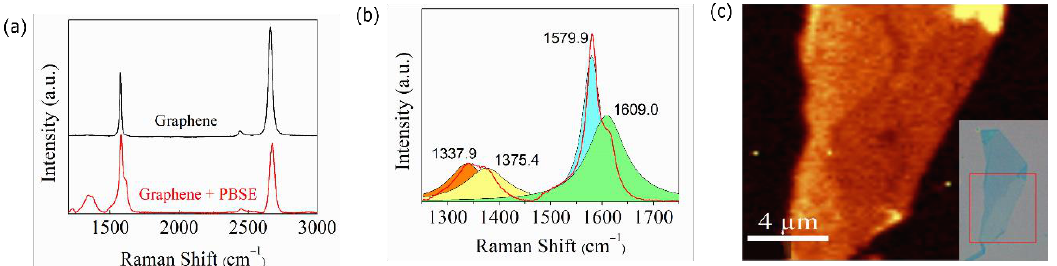
Figure 3. ( a ) Raman spectra of a graphene monolayer before (black curve) and after (red curve) 1-pyrenebutanoic acid succinimidyl ester (PBSE) immobilization. The top curve is shifted for clarity. ( b ) Raman spectrum near G band. ( c ) Raman spectra color map of the intensity of the peak at 1609.0 cm −1 for the region of the multilayer graphene flake shown in the inset (red square).